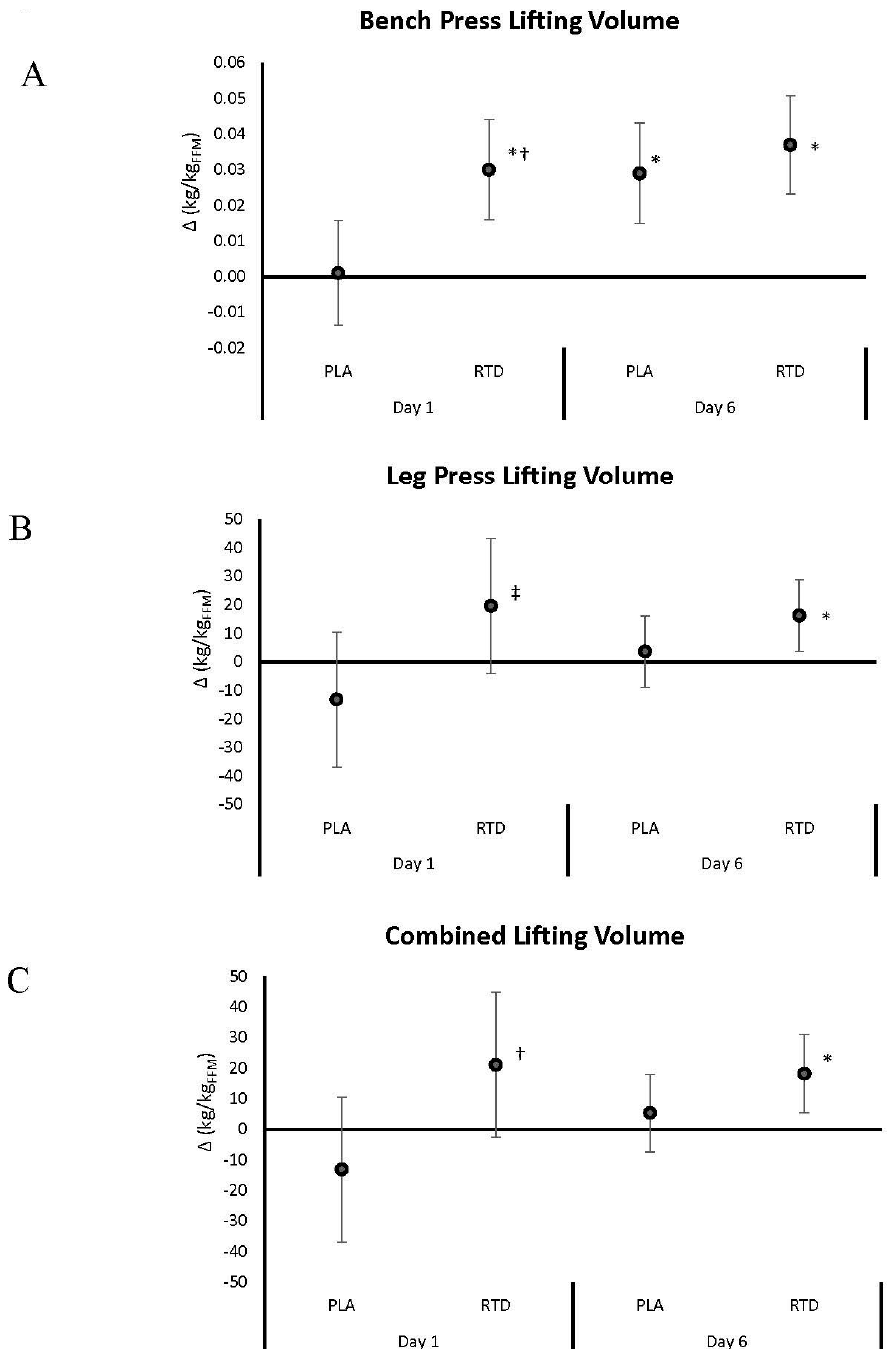
Figure 4. Data present mean change (95% CI) in bench press ( A ); leg press ( B ) and total (combined) lifting volume; ( C ) from baseline. Confidence intervals not crossing zero are statistically significant ( p < 0.05). * Represents p < 0.05 difference from baseline, † represents p < 0.05 difference between treatments. ‡ Represents p > 0.05 to 0.10 tendency towards significance between treatments.